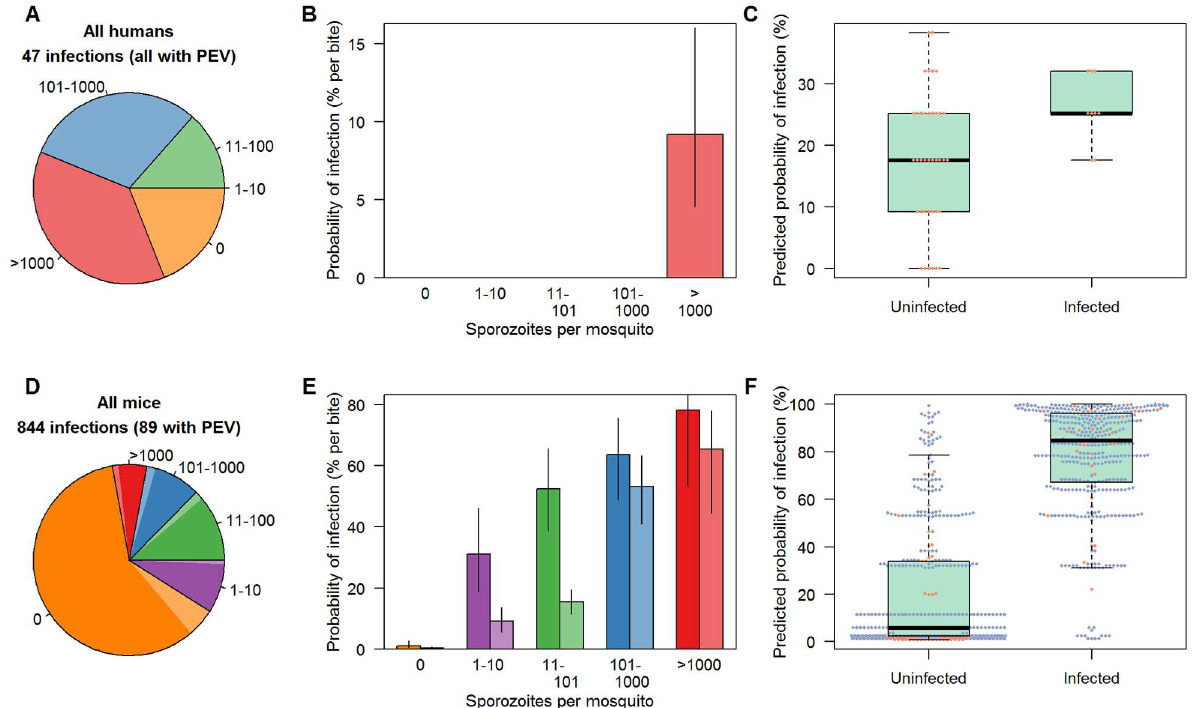
Fig 1. The association between the number of salivarygland sporozoites and the probability of infection in humans (A,B,C) and mice (D,E,F). In panelsA,B,D,E na ï veinfectionsare denotedby a darker shadeof colour whilst hosts given an anti-circumsporozoite protein vaccine or antibody(Pre-Erythrocytic Vaccine-PEV) are a lighter shade. Unvaccinated control humans are excludedfrom the analysisin (A-C) as all receivedvery high levels of parasitechallengeand all developed infection (so there is no variabilityto test the associationwith residual-sporozoite load). Panels (A) and (D) show the numberof sporozoites in the salivary glands followingblood- feedingused in the different experimental infections(be it 0 (orange),1–10 (purple),11–100(green), 101–1000 (blue) or > 1000(red). Panels (B) and (E) show model predictionsof the probabilitythat a single bite from a mosquitowith a given number of salivary gland sporozoites followingblood-feeding will inducepatent infection(black lines show 95% confidenceinterval estimates on model predictions). Panels (C) and (F) show model predictionsfor overall probabilityof infectionfor each individual human and mouse and as estimated using the best fit model. Each point gives the predictionfor an individual volunteeraccordingto the numberof bites they receive, the residual- sporozoitescore of those individualbites (taken from panel (B) and (E) and whetherthey receiveda PEV (orangedots) or were untreated (blue dots).